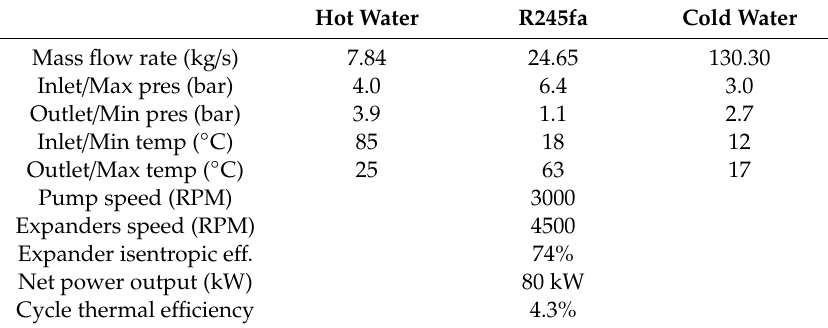
Table 3. Results from the one-dimensional model at design